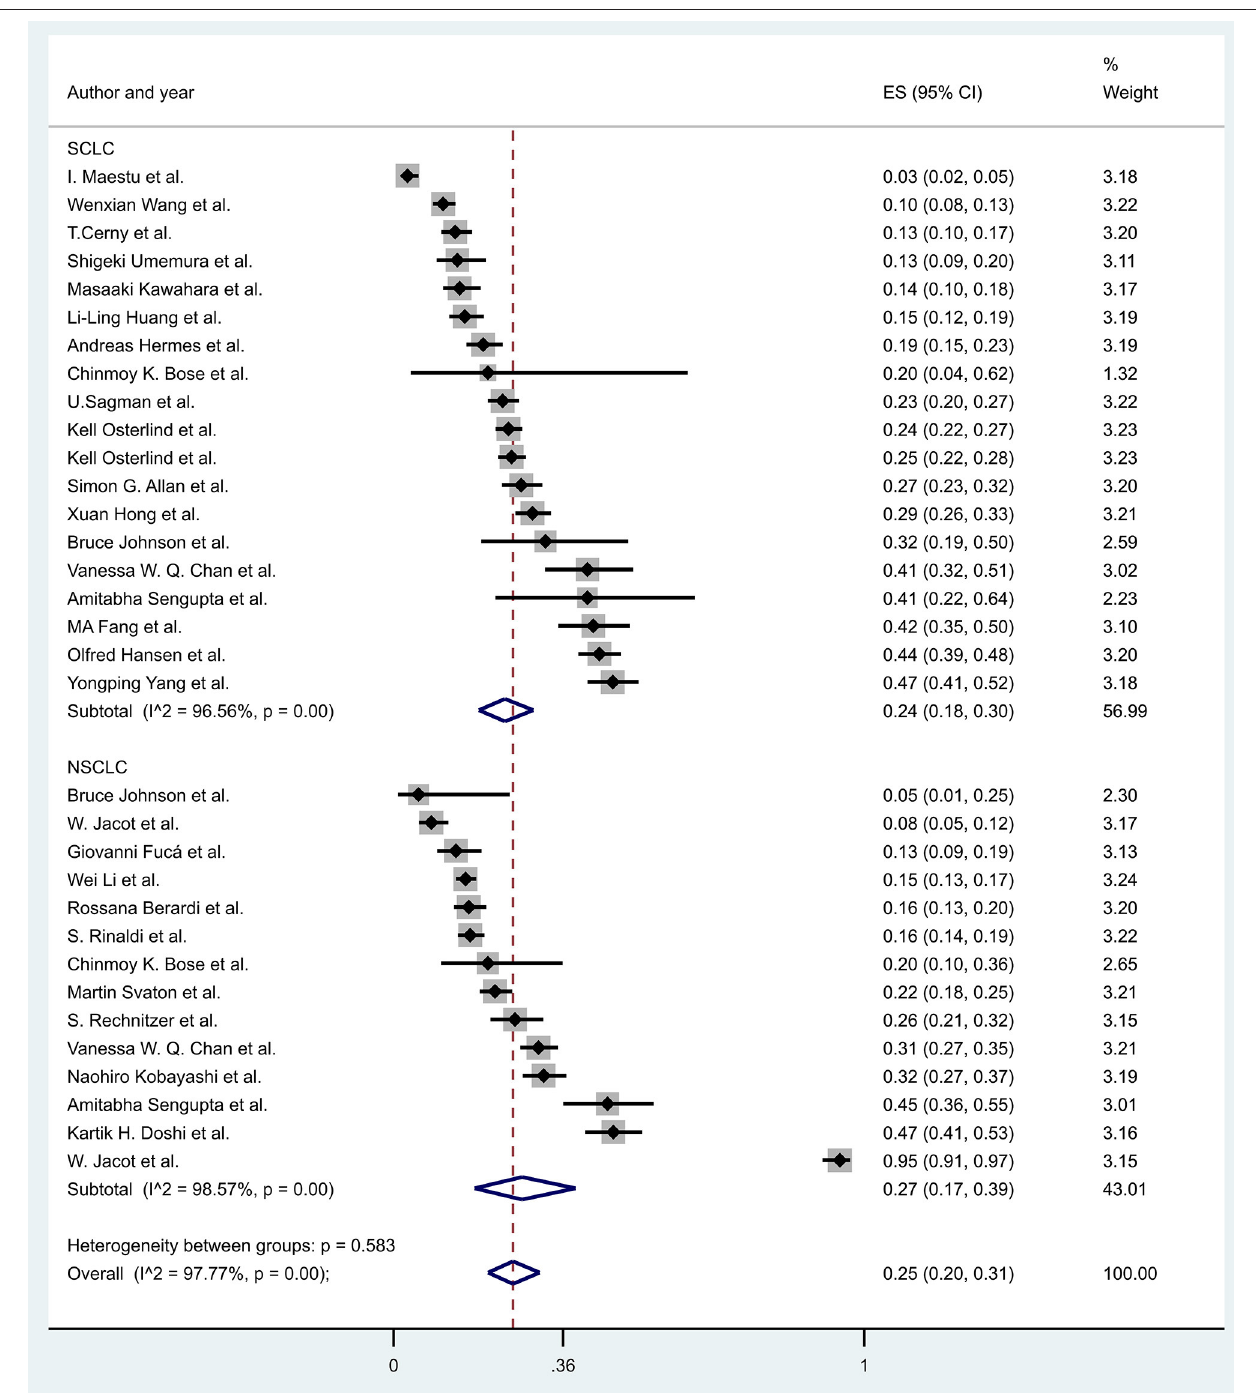
FIGURE 2 | The prevalence of hyponatremia in patients with SCLC and NSCLC. Black diamonds represent the effect and vertical lines of the individual studies show the corresponding 95% CI. The size of the gray squares reflects the weight of a particular study. The blue diamond is the overall or summary effect. The outer edges of the diamonds represent the CIs. SCLC, small cell lung cancer; NSCLC, non-small cell lung cancer; ES, effect size.